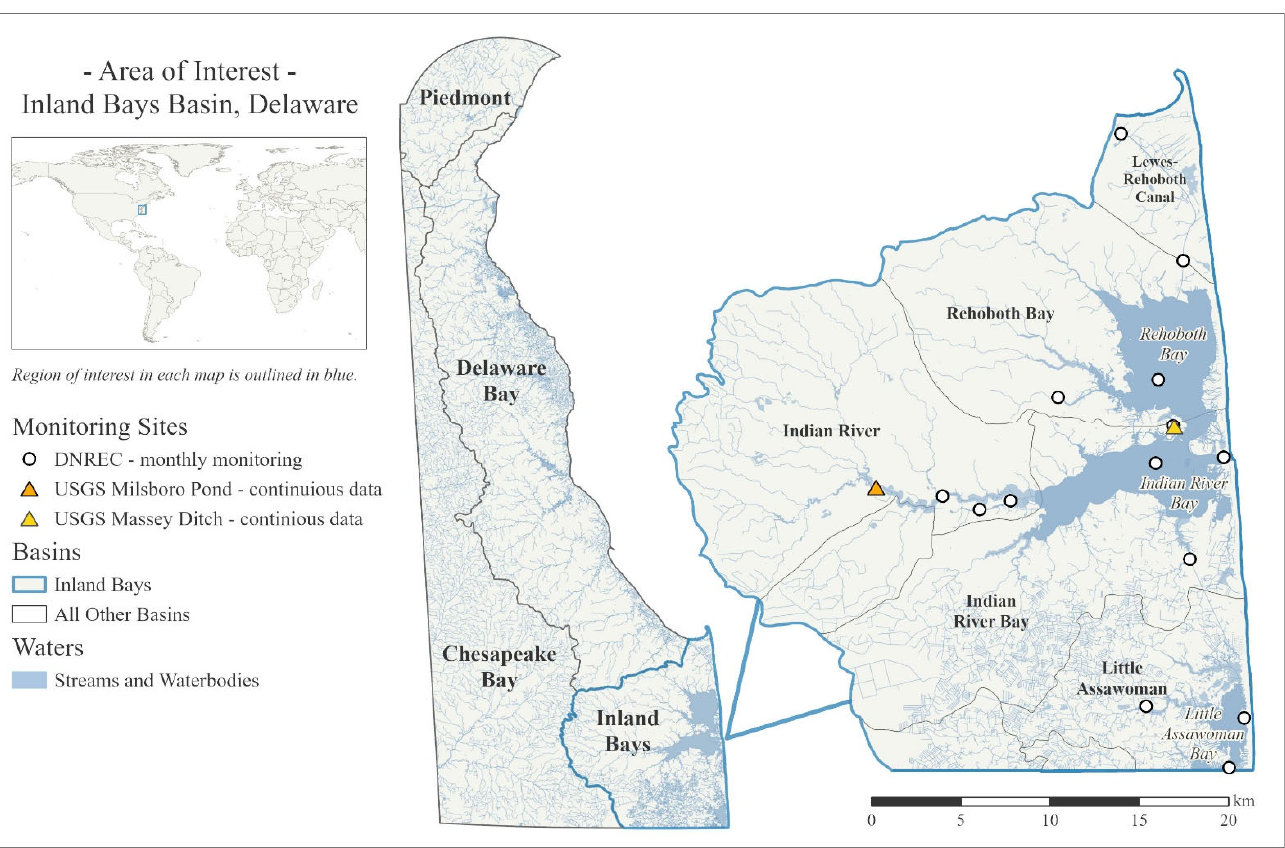
Figure 1. Delaware Inland Bays with sampling and United States Geological Surveys continuous monitoring stations.